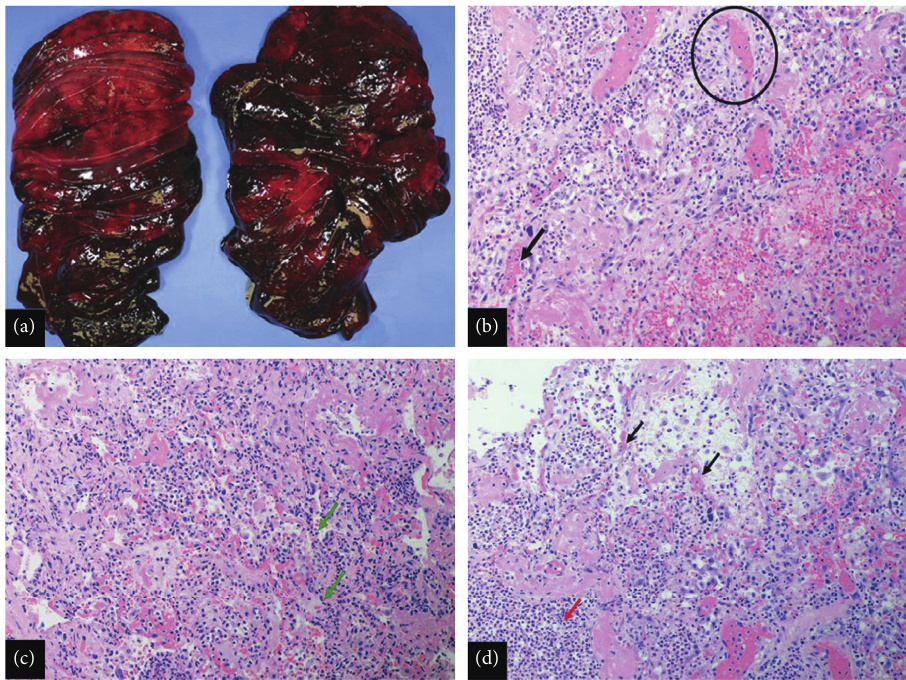
Figure 2: Gross image of the right and left lungs (a) shows diffuse bilateral hemorrhage worse in the lower lobes. Microscopically, there is diffuse alveolar hemorrhage with arterial thrombi (circle, b), capillary microthrombi (black arrows, b and d), foci with acute inflammation and capillaritis (green arrows, c), and acute pneumonic consolidation (red arrow, d) (panels b, c, and d, hematoxylin and eosin stains, magnification, 20x).